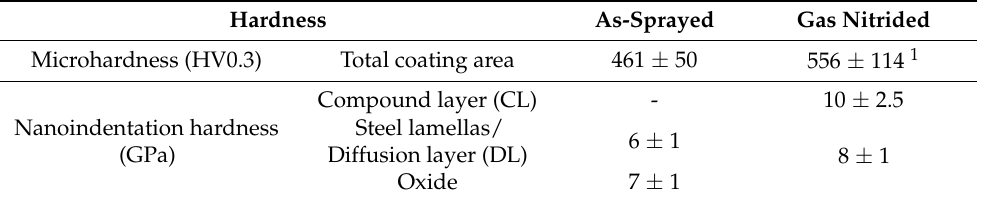
Table 3. The hardness of the arc sprayed 17Cr-steel coatings in the as-sprayed and gas nitrided condition.